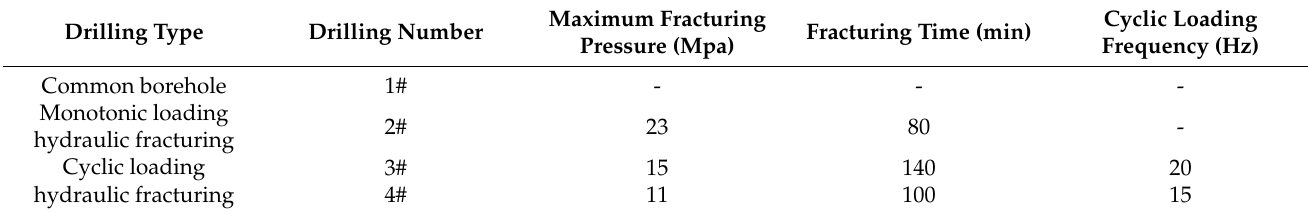
Table 2. Drilling parameters.